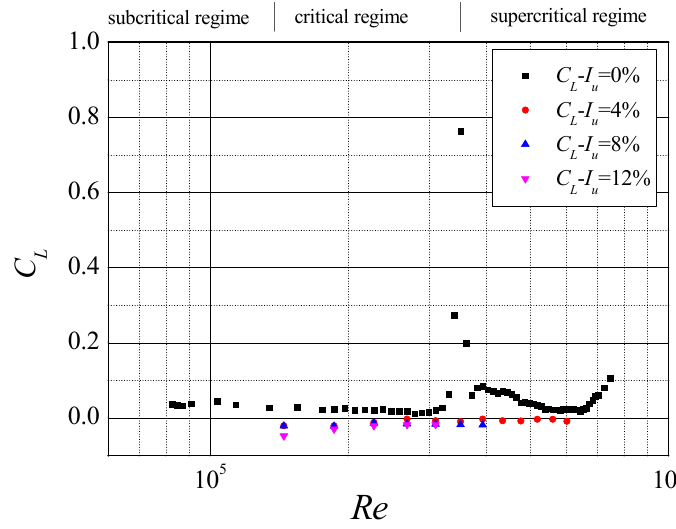
Figure 19 . Lift coefficient of circular cylinder in turbulent flow. Figure 19. Lift coe ffi cient of circular cylinder in turbulent flow.